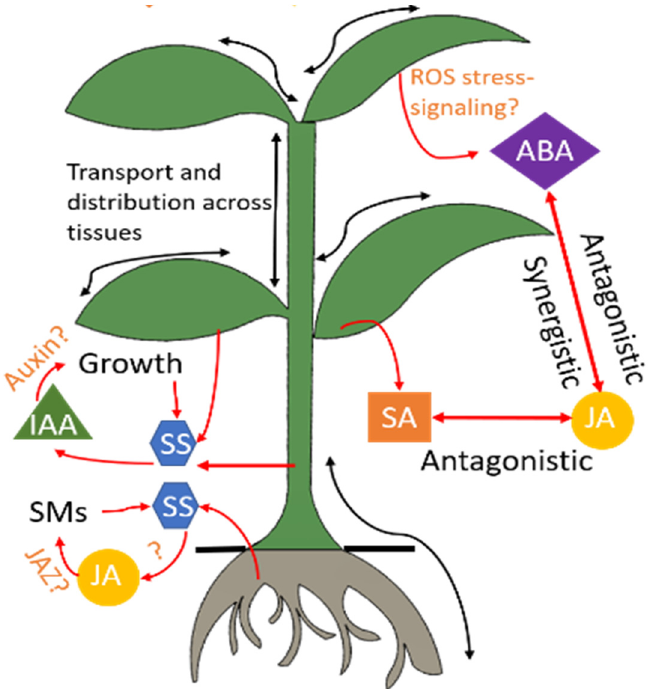
Figure 2. Hormonal regulation in the plant. Stress conditions trigger a cascade of phytohormones. Several signaling pathways of these hormones are still under research and hence indicated by the symbol “?.” Advanced sensors will advance understanding of these interactions through in ‐ situ and